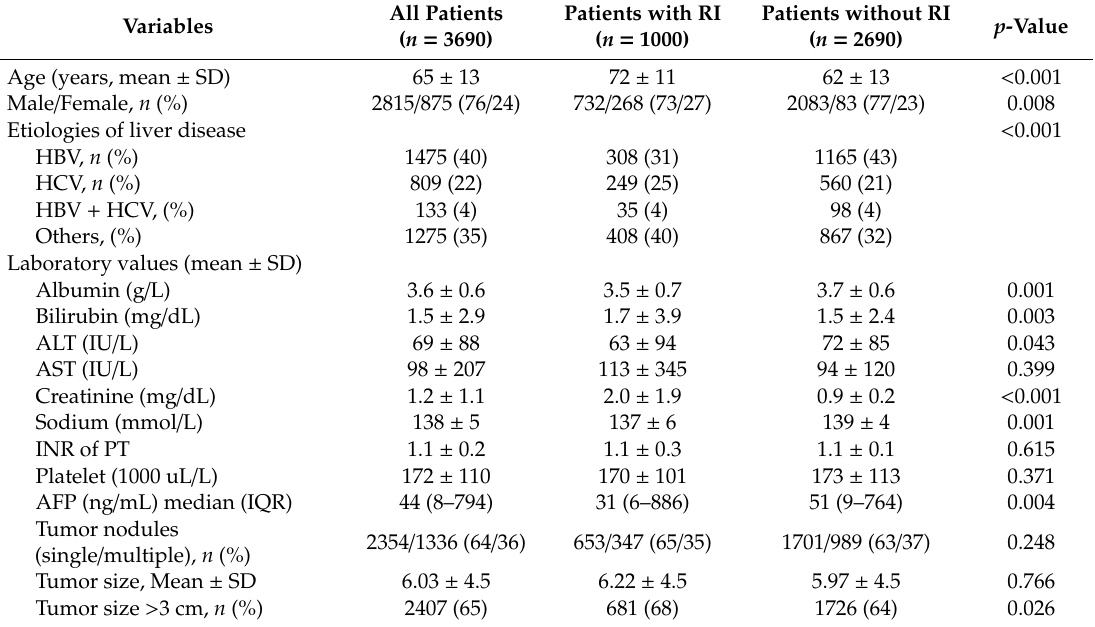
Table 1. Comparison of baseline characteristics of hepatocellular carcinoma (HCC) patients with and without renal insufficiency (RI).